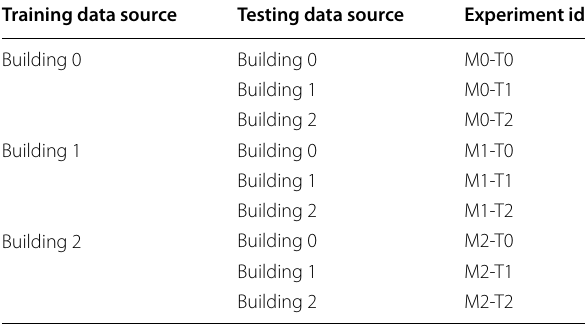
Table 3 The different experimental test